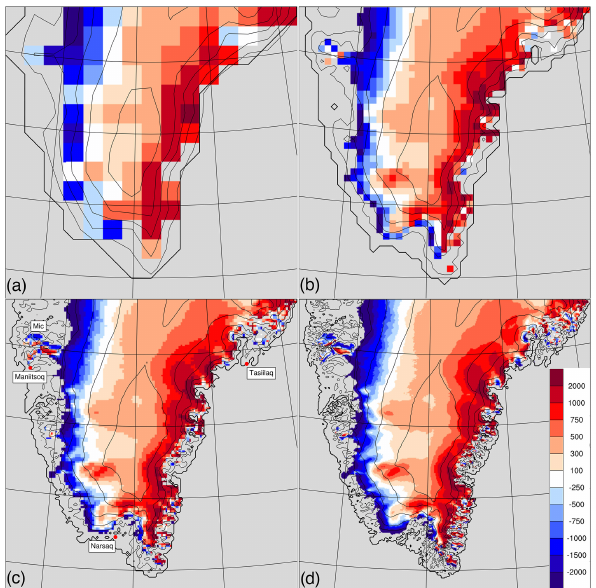
Figure 2. Annual mean SMB (mmw . e . a − 1 ) for the period Octo- ber 2007 till September 2014 derived with RACMO2 with a reso- lution of (a) 60, (b) 20, (c) 6.6, and (d) 2.2km. Grid points outside the ice sheet mask are grey. In (c) , Mic is used as an abbreviation for the Maniitsoq ice